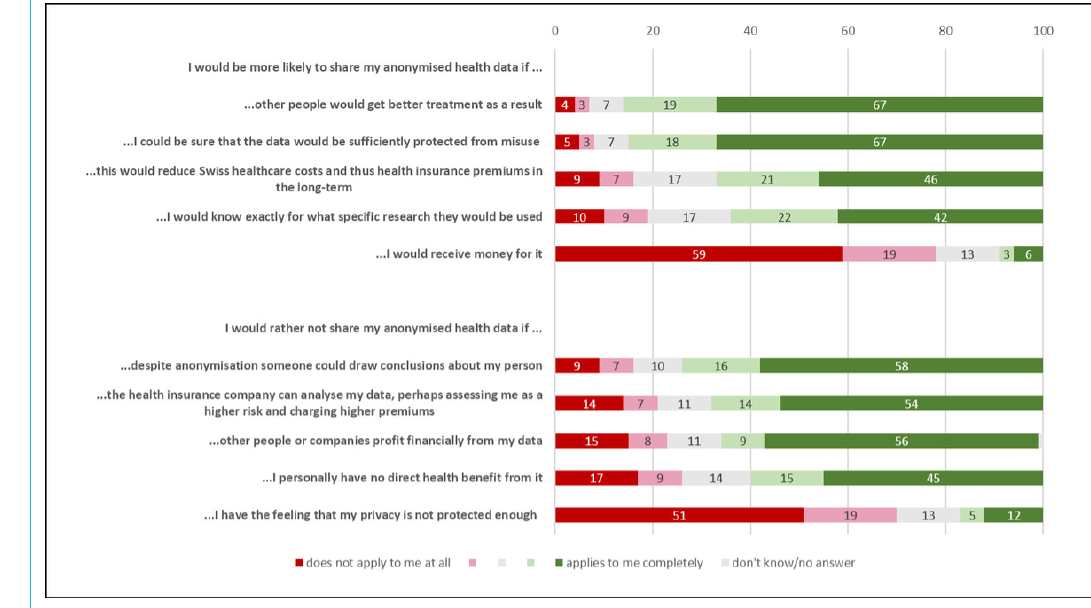
Figure 3: Agreement to potential drivers and barriers affecting the willingness to share health data for medical research (general population, N = 1006). The different categories are presented in